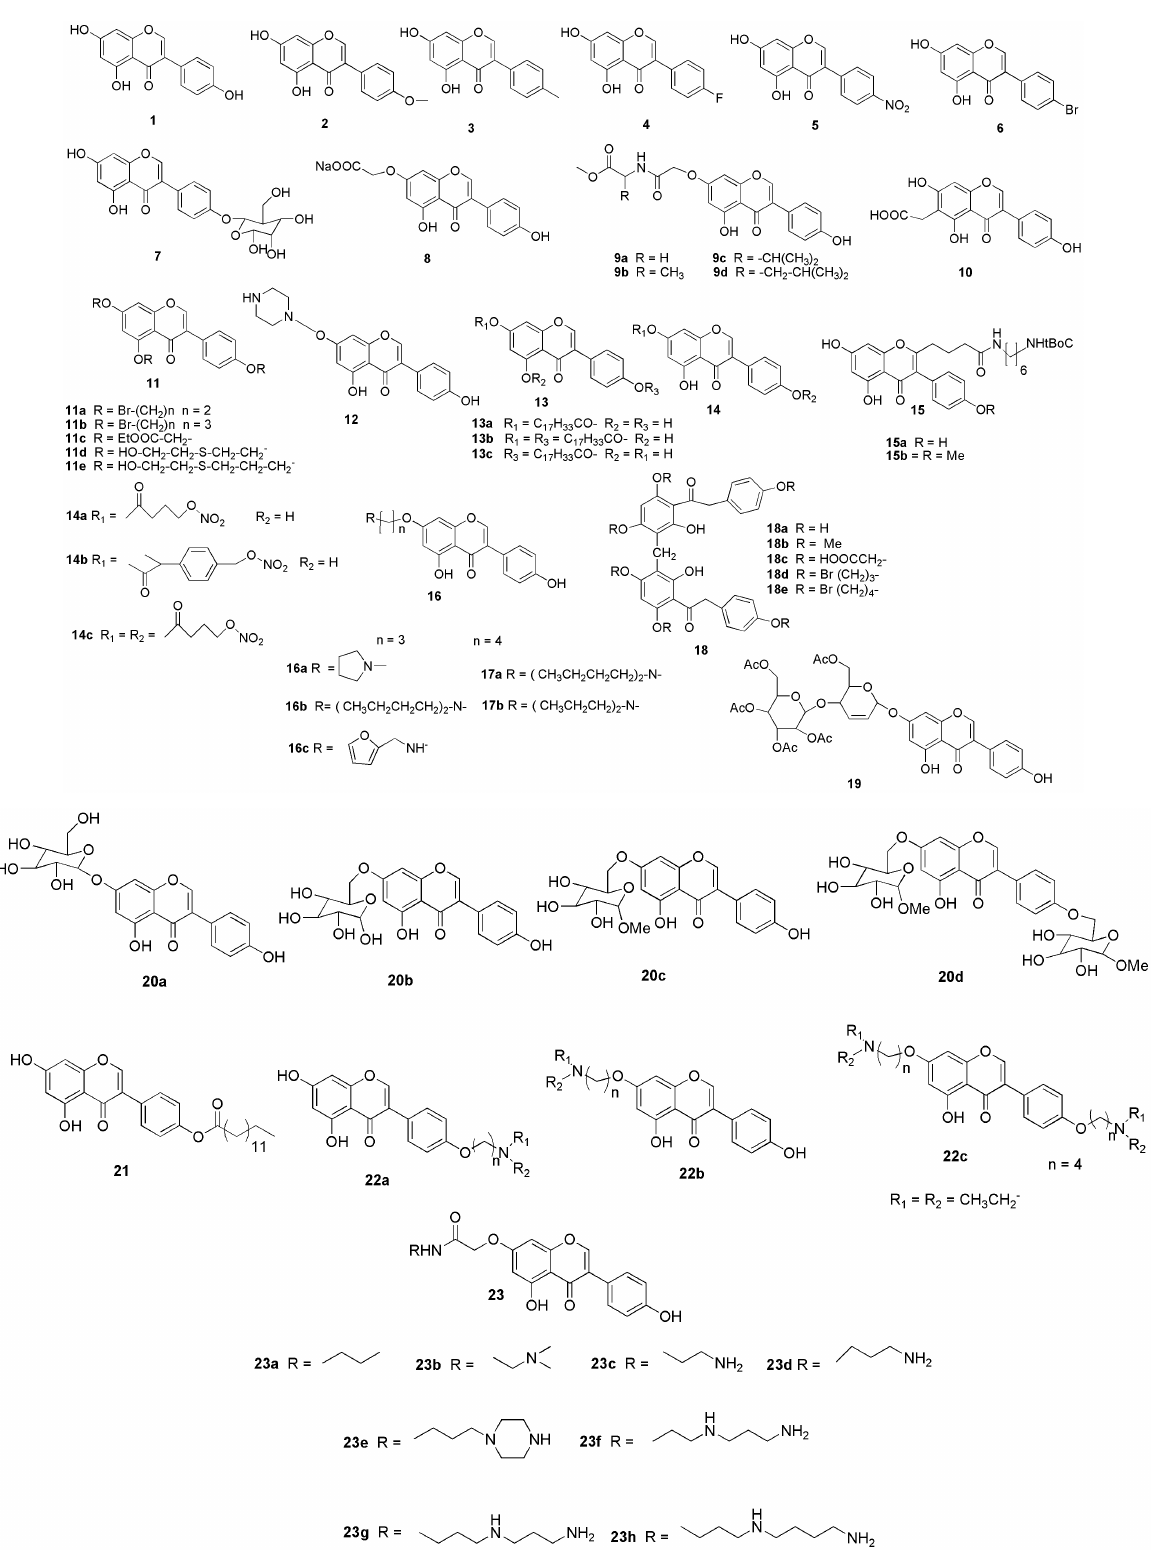
Figure 6. Possible structural modifications and derivatives of genistein.